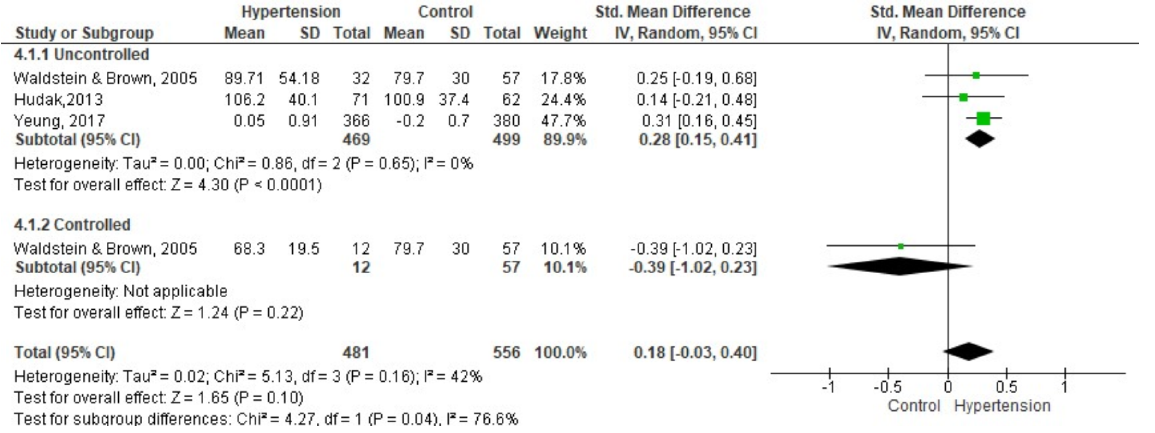
Figure 3. Meta-analysis on the comparison of groups with controlled and uncontrolled hypertension between the control group in working memory. High score indicates lower